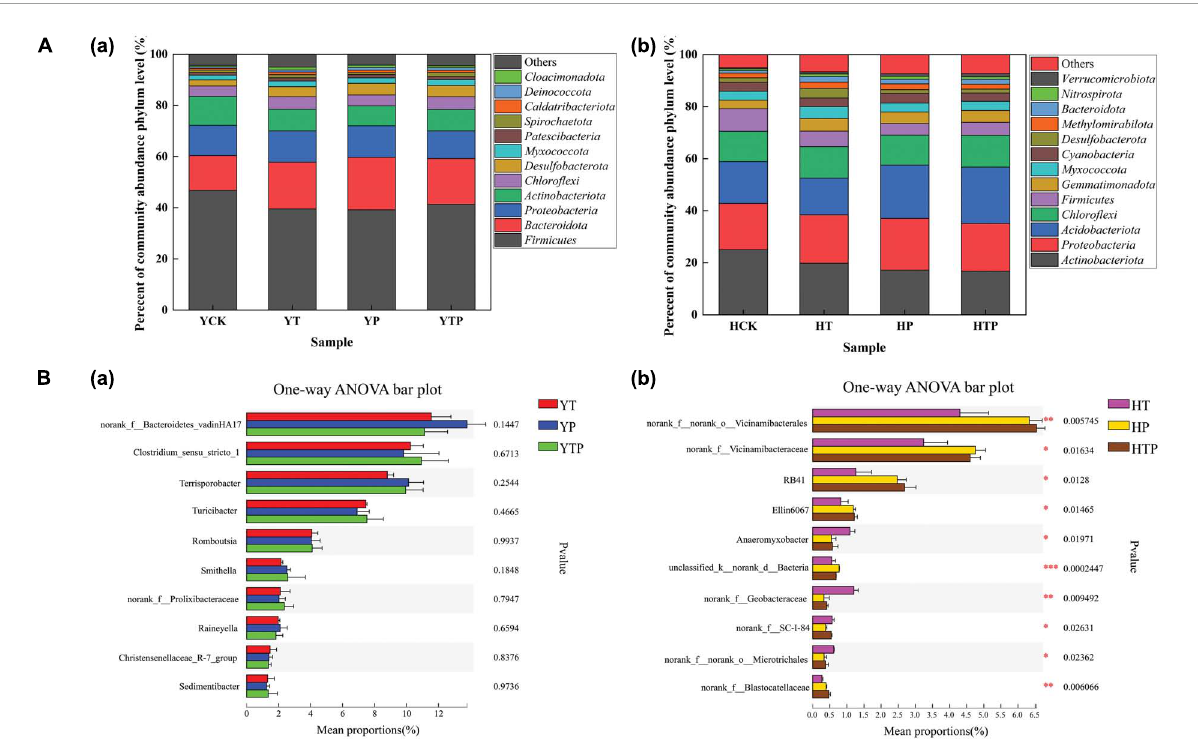
FIGURE5 Dynamics of the bacterial community under different treatment. (A) Relative abundance of bacterial taxa at the phylum level in pig farm sediment and riverbed sediment. (B) The One-way ANOVA to compare bacterial community structure changes, (a) Bacterial community structure changes at genus level in pig farm sediment, (b) Bacterial community structure changes at genus level in riverbed sediment. YCK refer to the pig farm sediment for 30 days, HCK refer to the riverbed sediment for 30 days. ∗ p < 0.05, ∗∗ p < 0.01, ∗∗∗ p <